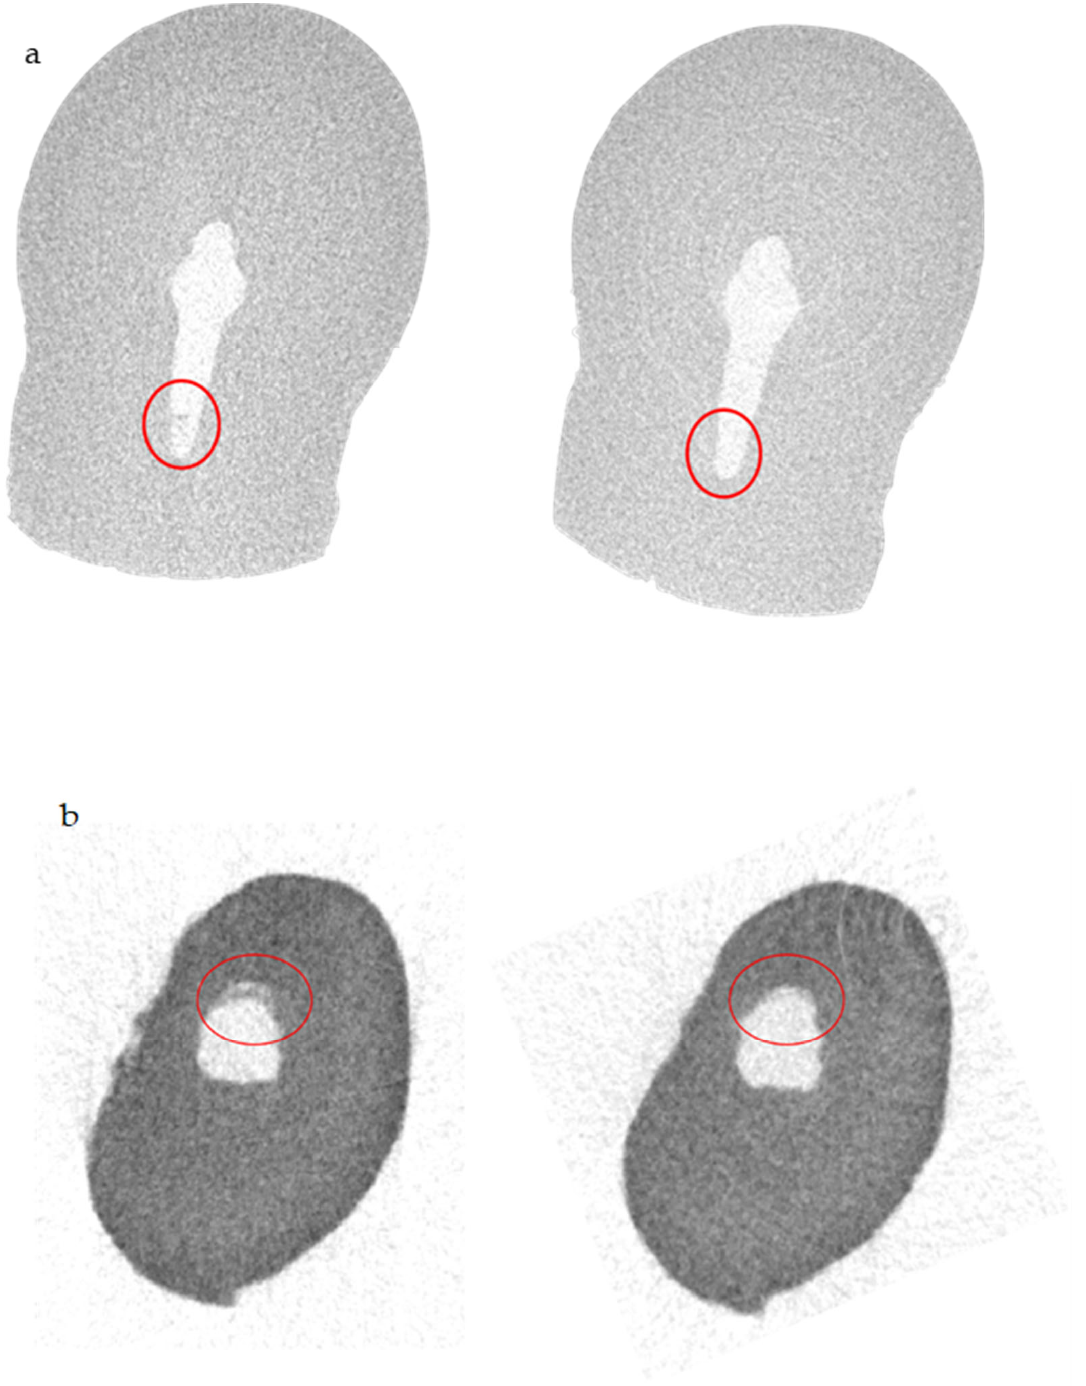
Figure 3. EB group—slice evaluation of ATHD: ( a ) before (image left) and after (image right) activation at middle third; ( b ) before (image left) and after (image right) activation at apical third.